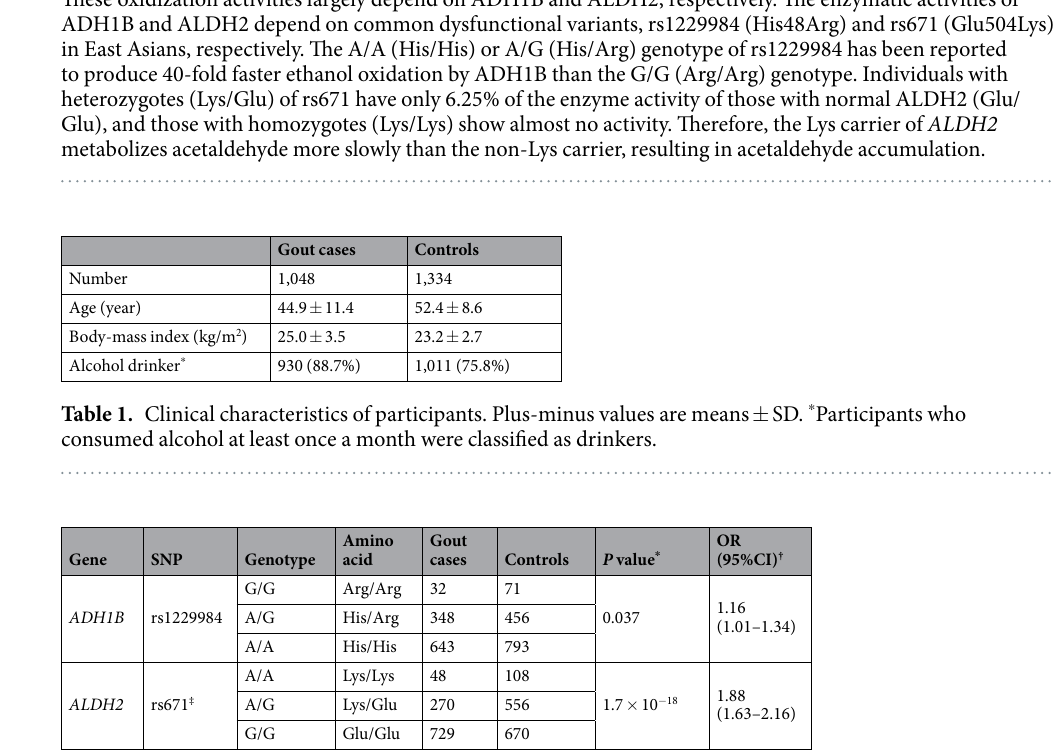
Table 2. Association analysis between gout and two common variants of ADH1B and ALDH2 . Abbreviations: SNP = single nucleotide polymorphism; OR = odds ratio; CI = confidence interval; His = histidine; Arg = arginine; Glu = glutamic acid; Lys = lysine. * The P values were calculated using logistic regression analysis. † The ORs were calculated per allele model. For rs1229984 (His48Arg), “A” is the risk allele. For rs671 (Glu504Lys), “G” is the risk allele. ‡ The genotyping results of rs671 are obtained from our previous report 12